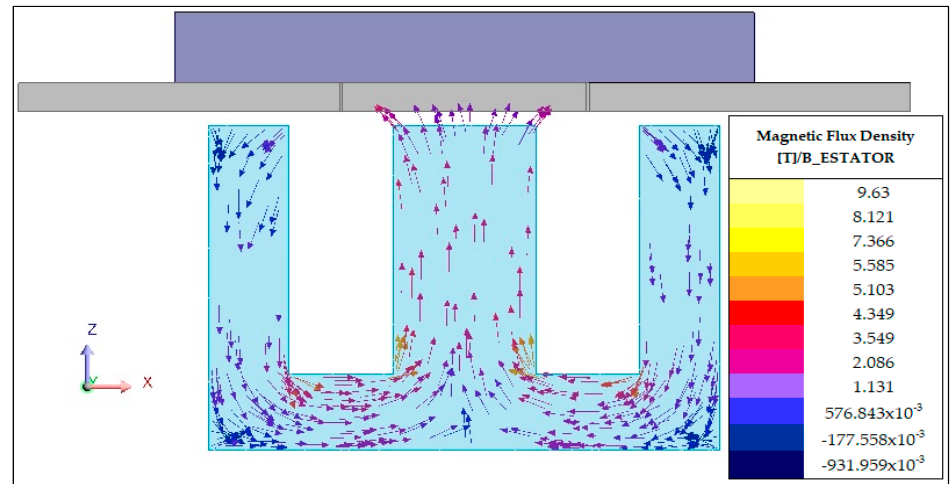
Figure 10. Transversal view of magnetic flux in model 1.